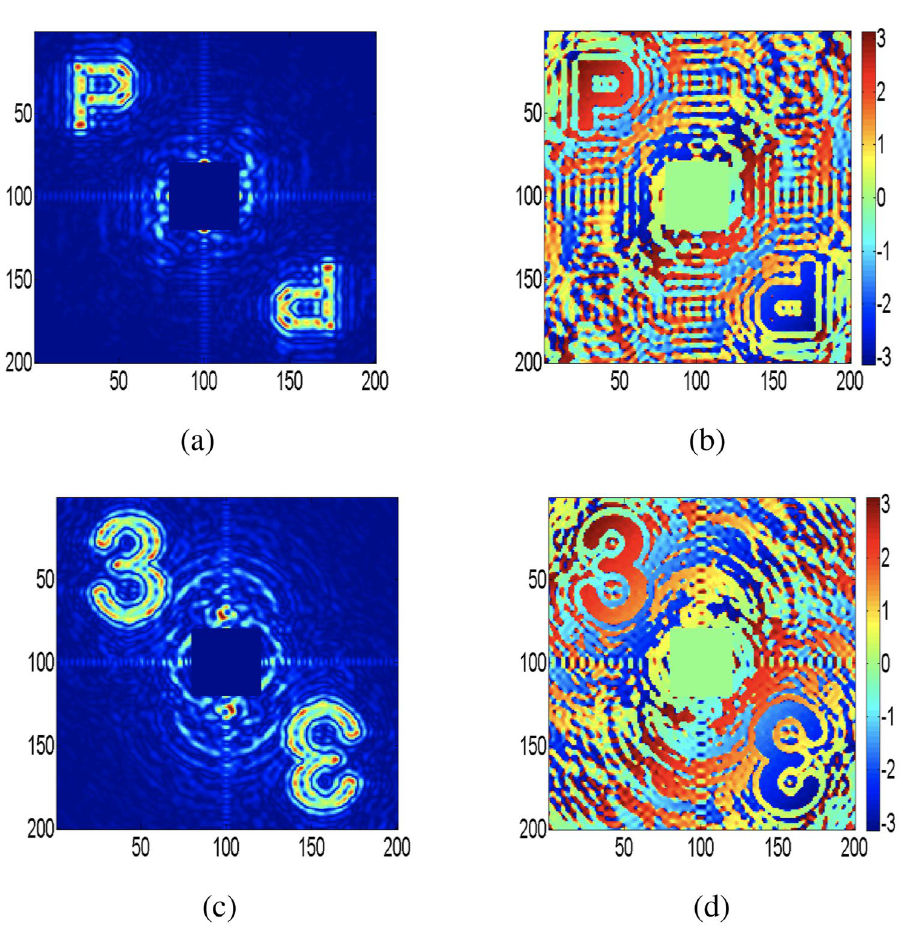
Figure 4. Recovery of complex fields without RGG from holograms of objects, letter “P” and number “3” ( a ) Amplitude distribution of letter “P” ( b ) Phase distribution of letter “P” ( c ) Amplitude distribution of number “3” ( d ) Phase distribution of number